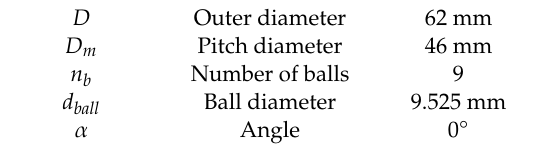
Table 3. Bearing dimensions